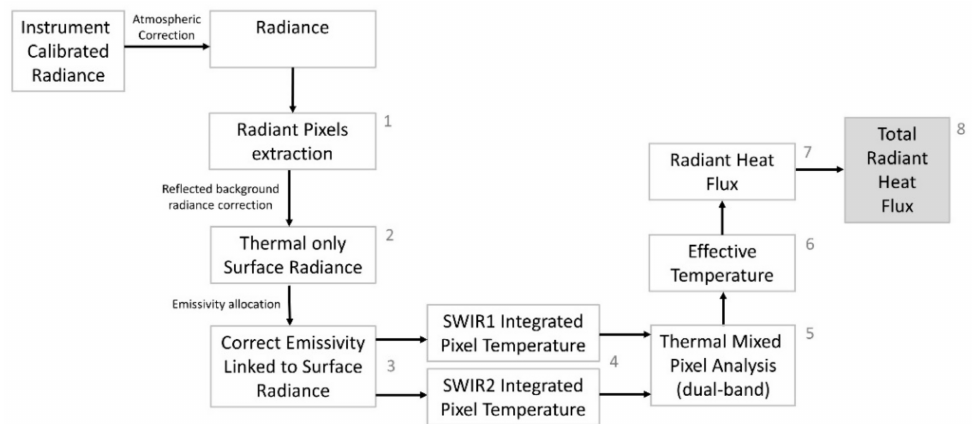
Figure 3. A flowchart illustrating methods (steps 1–8) to derive radiant heat flux using high-spatial resolution data (ETM+) in two SWIR